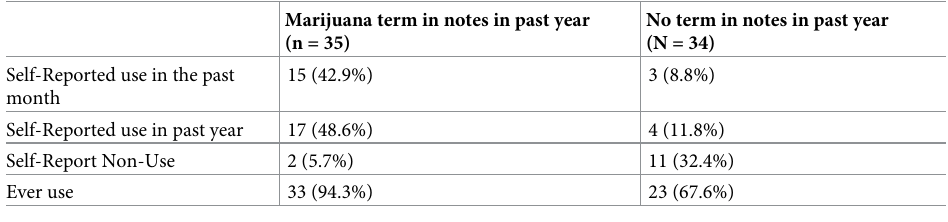
Table 1. Concordance between text search method and patient